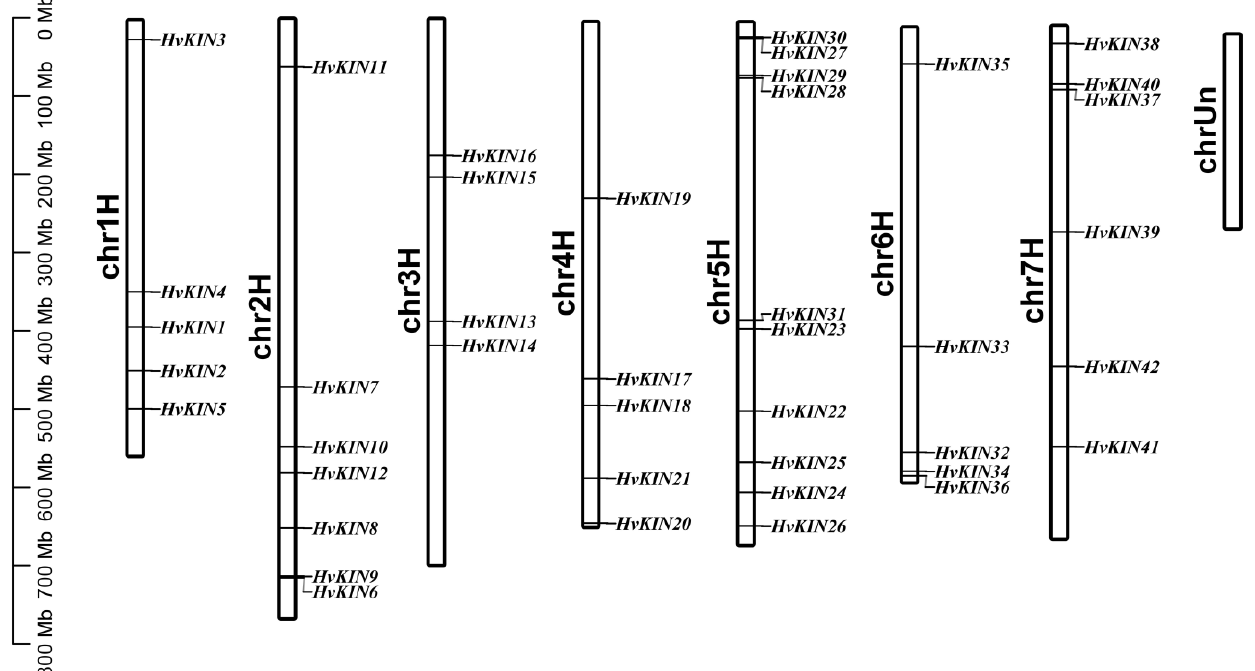
Figure 2. KIN genes distribution on barley chromosomes. Note: Each bar has a chromosomal number above it. The base pair scale is on the left (bp).